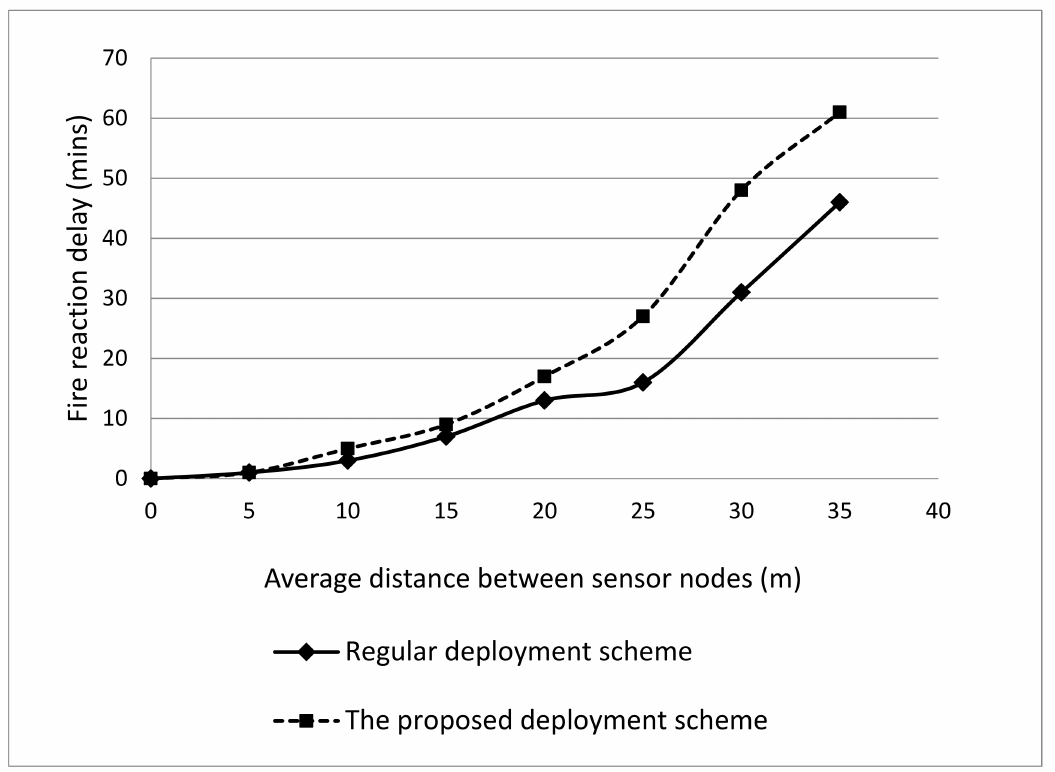
Figure 4. Fire reaction delay for various average distances between sensor